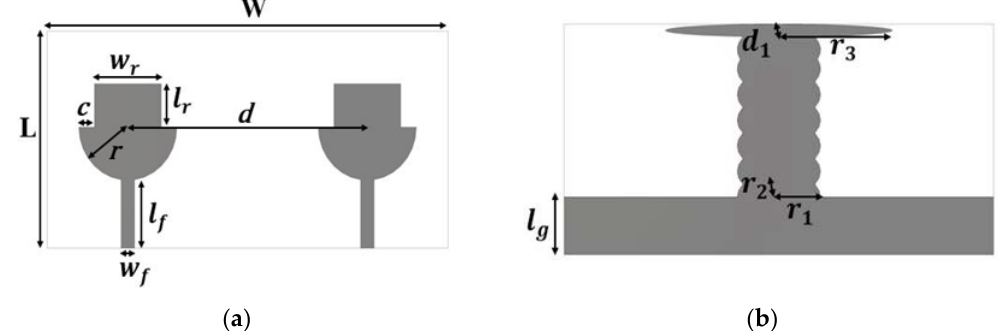
Figure 1. Design of MIMO antenna for SWB application. ( a ) Front view and ( b ) back view.